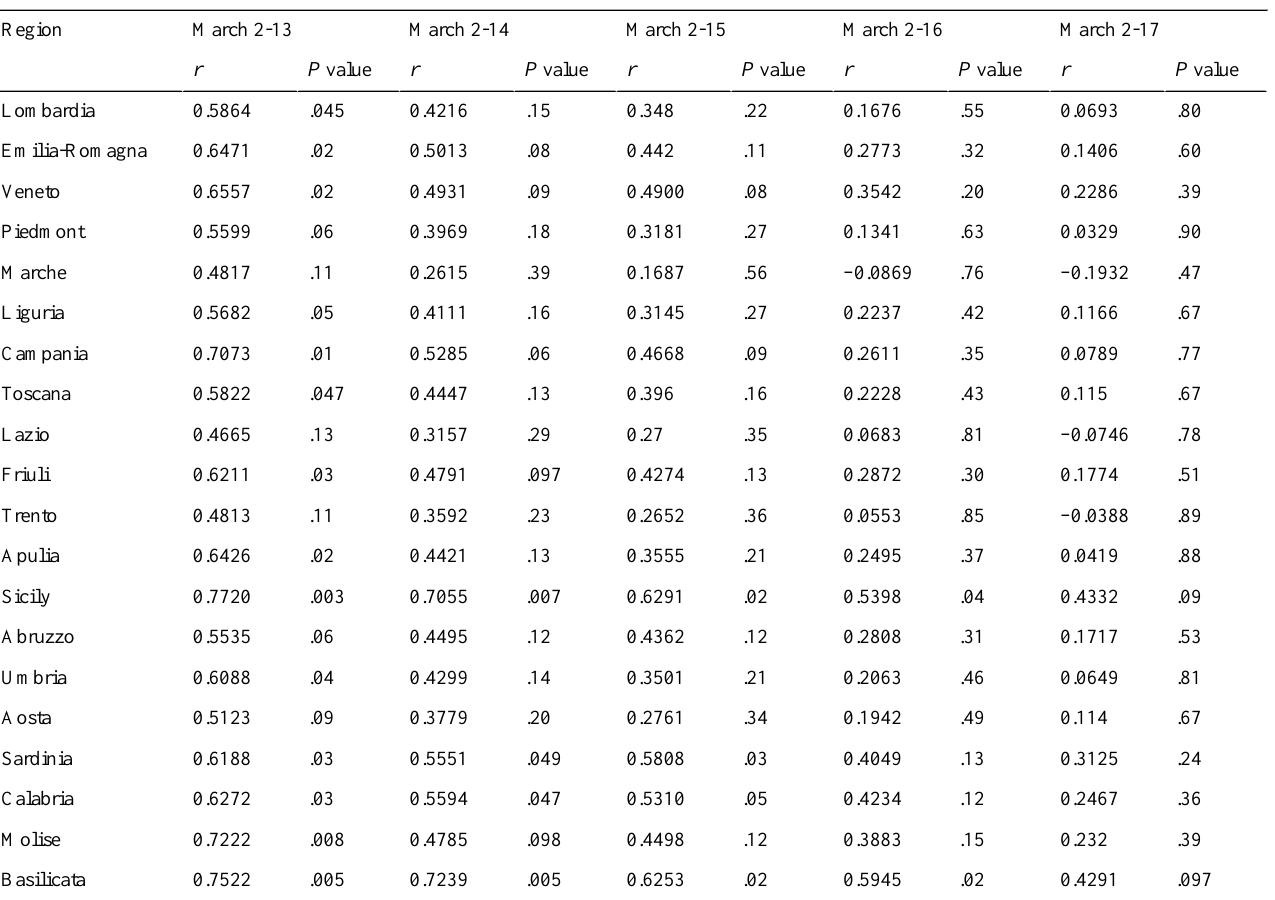
Table 4. Pearson correlation coefficients ( r ) between COVID-19 cases and Google Trends data in the 20 Italian regions for March 2-13; March 2-14; March 2-15; March 2-16; March